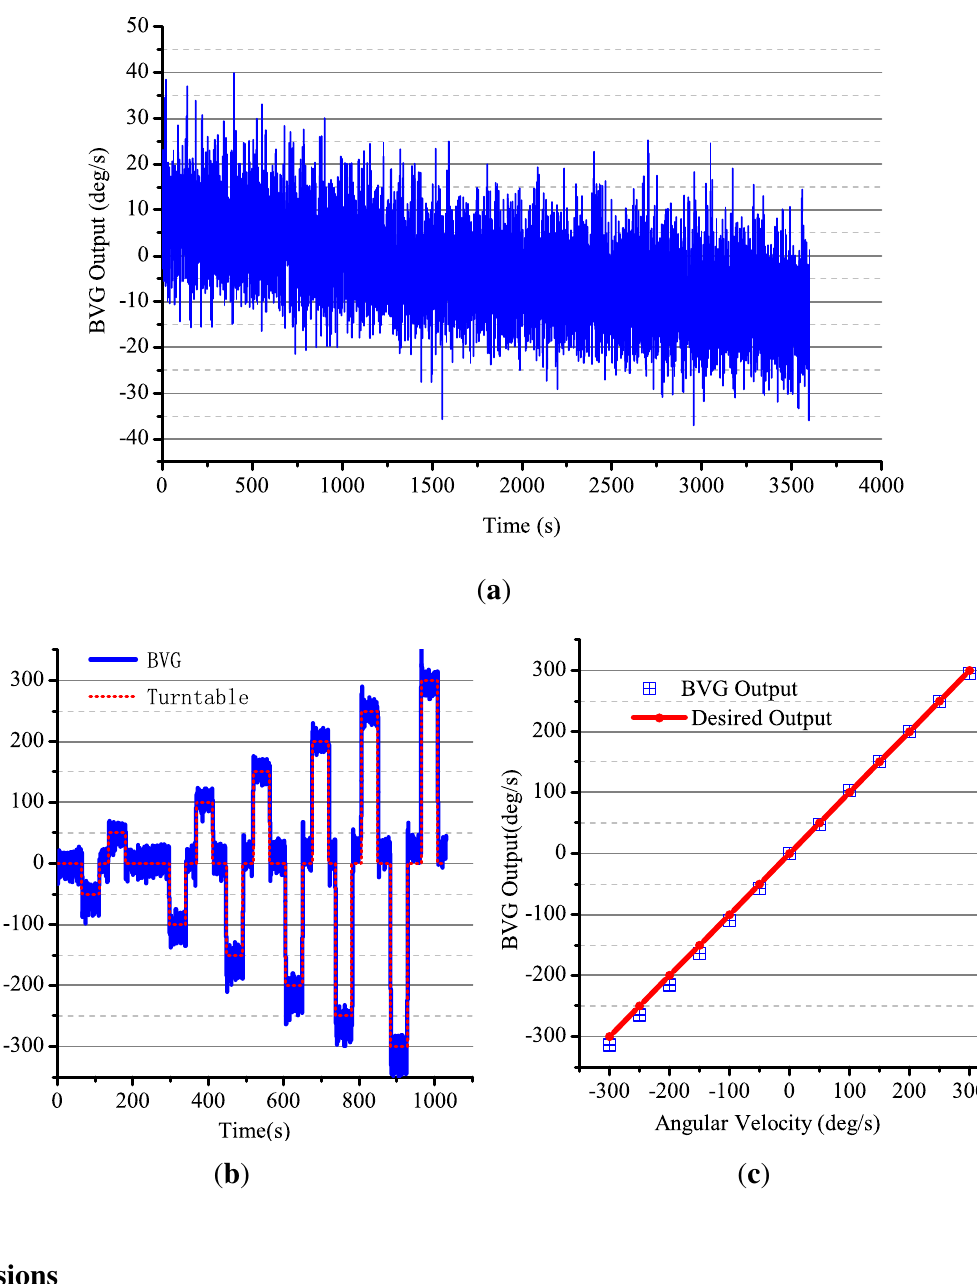
Figure 19. Experiment result. ( a ) Drift curve; ( b ) Range curve; ( c )